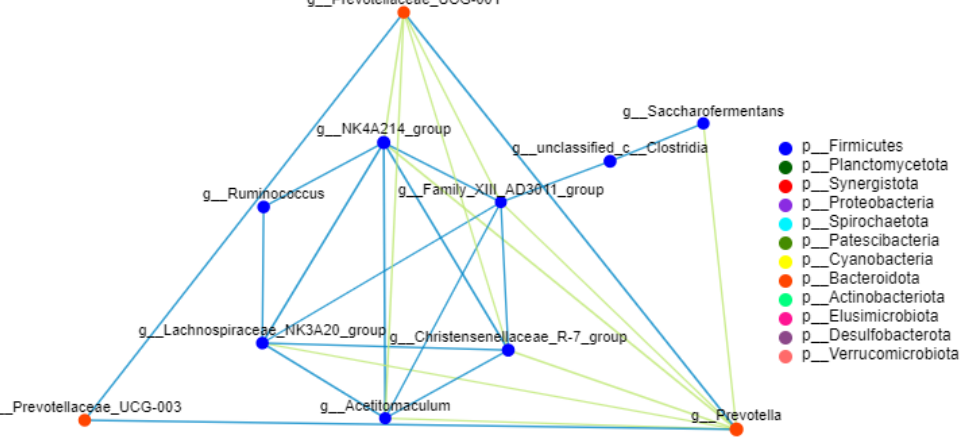
Figure 4. Correlation of rumen bacteria at the genus level. The correlation network is based on species at the genus level of rumen bacteria. Spearman rank and other correlation coefficients were calculated to reflect the correlation among species. By default, this figure shows the species information whose absolute value of correlation coefficient data is greater than or equal to 0.6 ( p < 0.05). The size of the nodes in the figure represents the size of species abundance. The colors of species (such as phyla) at the same taxonomic level are consistent; The color of the line indicates positive and negative correlations: blue indicates a positive correlation and green indicates a negative correlation. The thickness of the line indicates the size of the correlation coefficient; the thicker the line, the higher the correlation between species. More the number of lines, the closer the relationship between the species and other species.